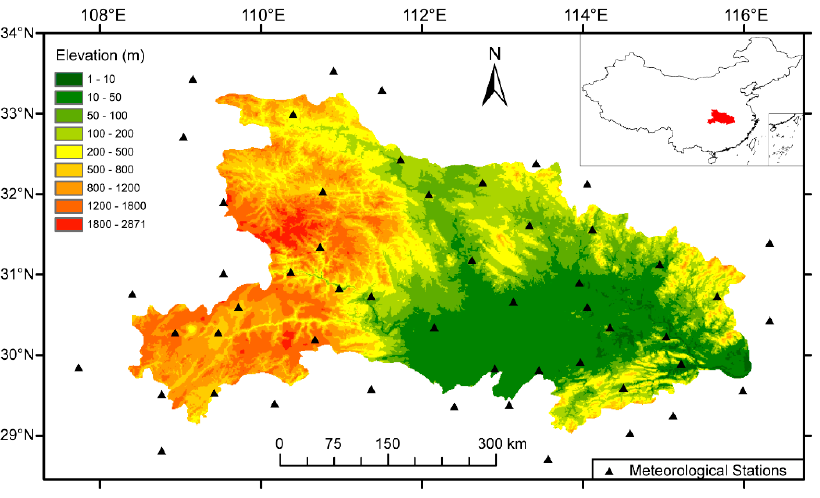
Figure 1. Location map of Hubei Province with elevation. The dark triangles denote the 52 meteorological stations used in this